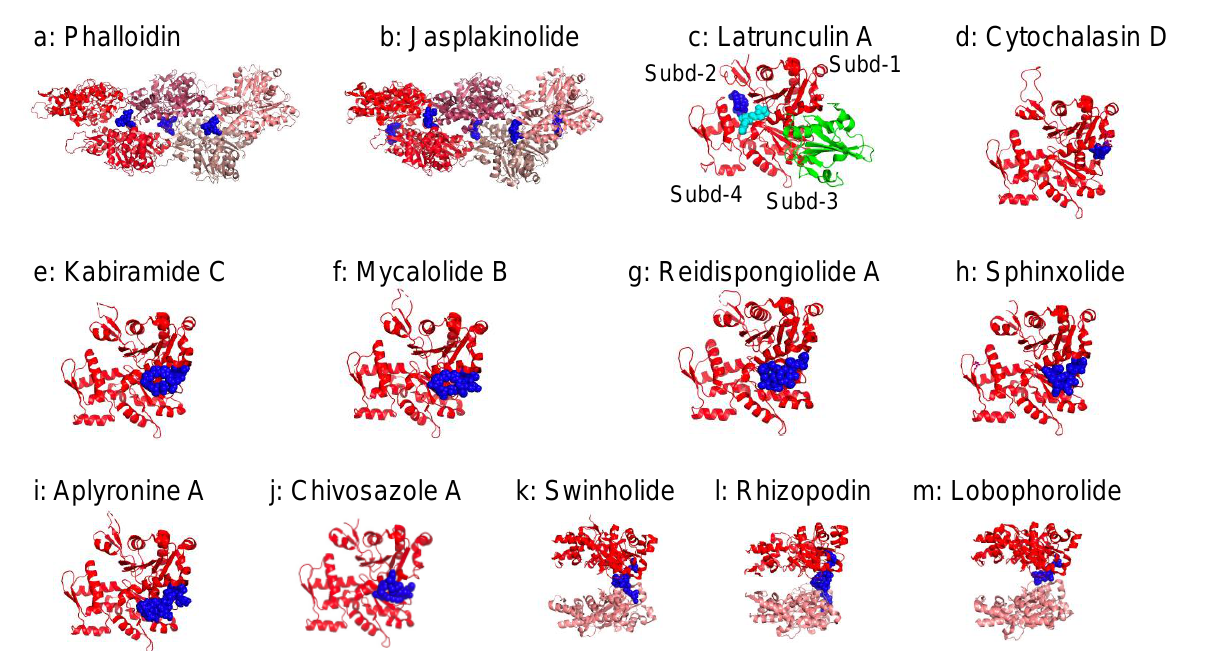
Figure 4. Actin-binding small molecules: ( a ) Phalloidin (7BTI [54]). ( b ) Jasplakinolide (6T23 [99]). ( c ) Latrunculin A, (1ESV [100], Gelsolin domain 1 is shown in green); subdomains of actin are indicated as Subd-1~4. ATP is shown in cyan. ( d ) Cytochalasin D (3EKS [101]). ( e ) Kabiramide C (1QZ5 [102]). ( f ) Mycalolide B (6MGO [103]). ( g ) Reidispongiolide A (2ASM [104]). ( h ) Sphinxolide (2ASO ([104]). ( i ) Aplyronine A (1WUA [105]). ( j ) Chivosazole A (6QRI [106]). ( k ) Swinholide (1YXQ [107]). ( l ) Rhizopodin (2VYP [108]). ( m ) Lobophorolide (3M6G [109]). Actin-binding small molecules are shown in blue. Actin shown from pointed (left) to barbed (right) end with red.